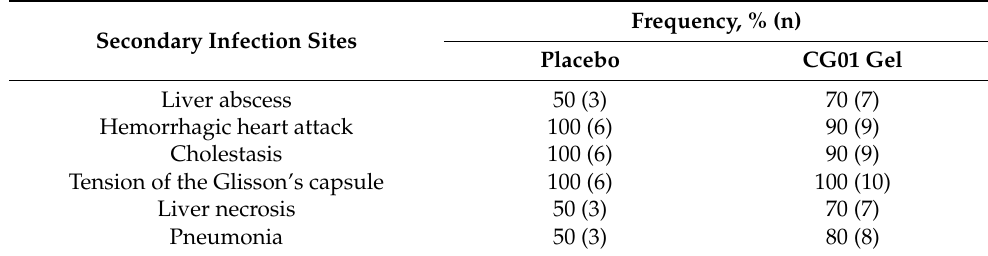
Table 2. The occurrence of pathological changes after infection in animals in the CG01 and placebo groups.